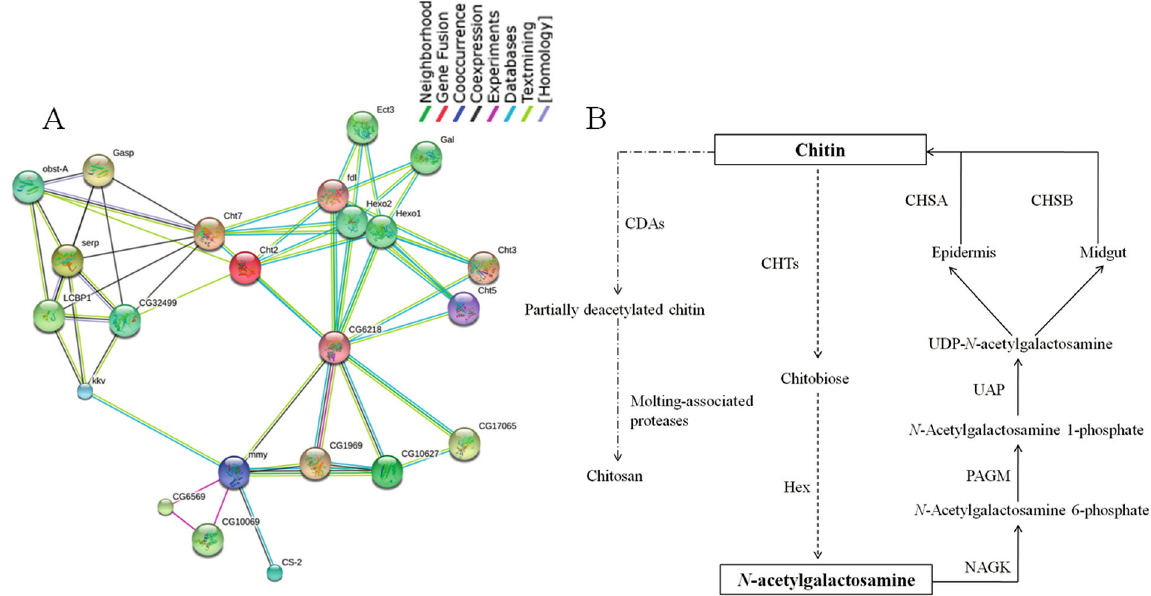
Figure 6. ( A ) Interaction networks of chitin enzymes associated with chitin biosynthesis based on the STRING website (focused on a specific protein network in Drosophila melanogaster ); ( B ) Chitin metabolic pathway and related genes in C. medinalis . The solid arrow indicates chitin biosynthetic pathway; The dotted arrow and chain line arrow indicates chitin degradation pathway; CDA: chitin deacetylase, UDP- N -acetylglucosamine pyrophosphorylase, PAGM: phosphoacetylglucosamine mutase, NAGK: N -acetyl- D -glucosamine